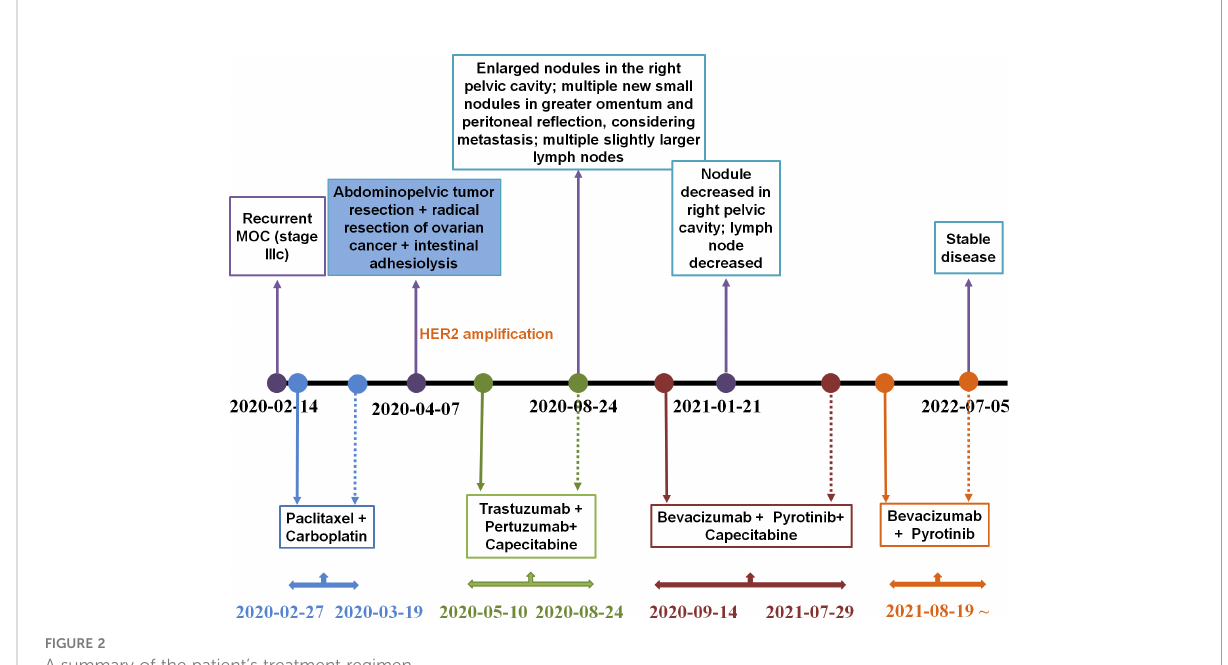
FIGURE 2 A summary of the patient ’ s treatment